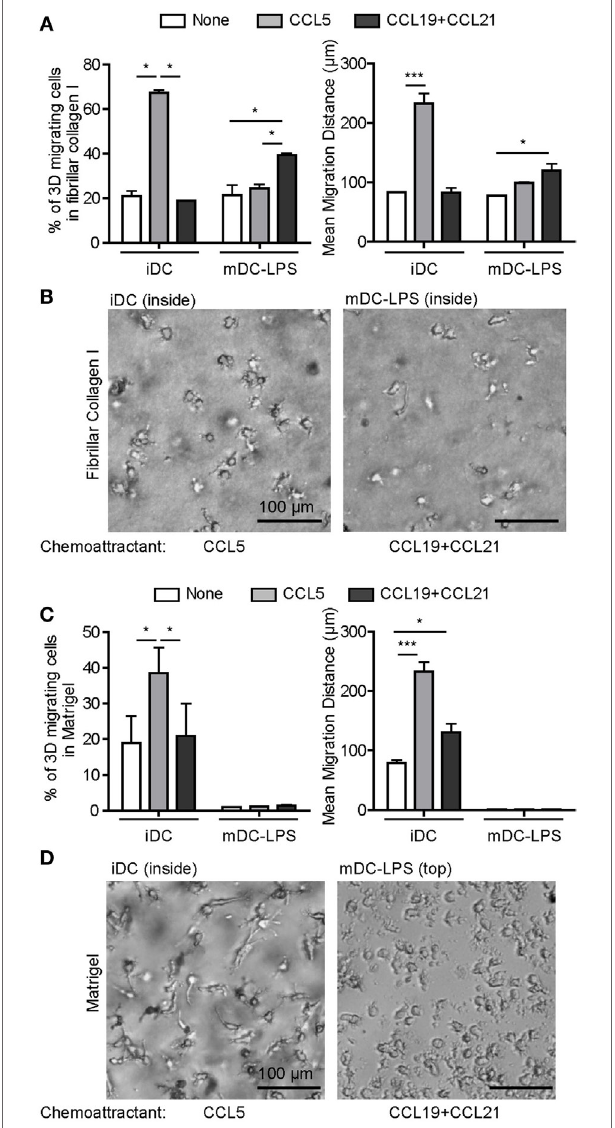
FigUre 3 | Chemokines regulate three-dimensional (3D) migration of dendritic cells (DC). (a) Immature DC (iDC) and mature DC (mDC)-LPS were seeded on top of a matrix of fibrillar collagen I and the percentage of migrating cells (left) or the mean migration distance (right) were monitored after 6 h, when none (white), CCL5 (gray), or a mixture of CCL19 and CCL21 (black) were added in the lower chamber as chemoattractant. Results are expressed as mean ± SEM of three independent experiments. * P < 0.05; *** P < 0.001 compared to iDC condition. (B) Bright field images of iDC and mDC-LPS within the matrix of fibrillar collagen I were taken using an inverted video microscope and illustrate the round cell morphology in response to CCL5 or a mixture of CCL19 and CCL21 chemokines, respectively. (c) iDC and mDC-LPS were seeded on top of Matrigel and the percentage of 3D migrating cells (left) or the mean migration distance (right) were monitored after 6 h, when none (white), CCL5 (gray), or a mix of CCL19 and CCL21 (black) were added in the lower chamber as chemoattractant. Results are expressed as mean ± SEM of three independent experiments. * P < 0.05; *** P < 0.001. (D) Bright field images of iDC within Matrigel were taken using an inverted video microscope and illustrate the elongated cell morphology in response to CCL5, while mDC-LPS remained on top of the matrix under the influence of CCL19 and CCL21